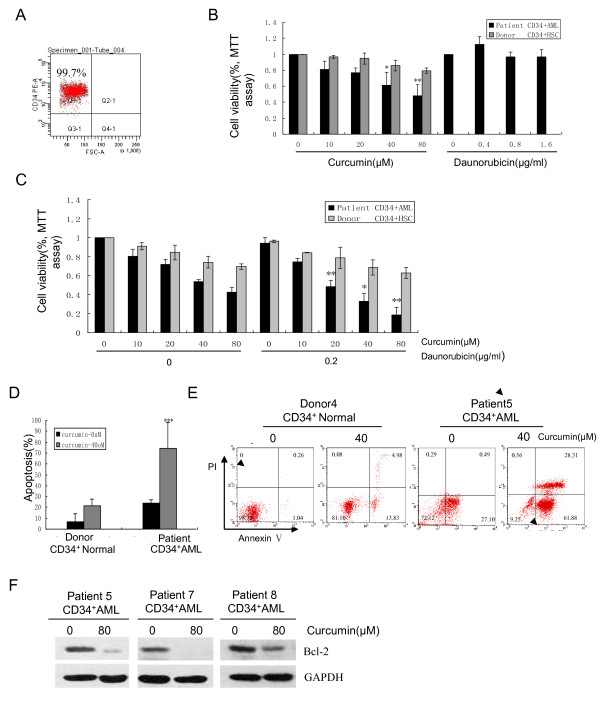
Curcumin was effective against primary CD34+ AML cells. (A) Primary CD34+ cells isolated from BMMCs or PBMCs of 9 AML patients and 8 healthy donors were isolated and subjected to flow cytometry to determine the purity of CD34+ cells. (B) 3 CD34+ AML and 3 CD34+ normal samples were treated with different concentrations of curcumin (0, 10, 20, 40, and 80 μM) for 24 h. The same CD34+ AML samples were also exposed to DNR (0, 0.4, 0.8, and 1.6 μg/ml) for 24 h. MTT assay was performed. The bar represents mean ± SD of three independent experiments. (C) Another set of 3 CD34+ AML samples and 3 CD34+ normal samples were exposed to different concentrations of curcumin, DNR, and their combination as indicated, for 48 h. MTT assay was performed. * P < 0.05, ** P < 0.01 (compared with either curcumin or DNR alone). (D, E) 4 CD34+ AML samples and 3 CD34+ normal samples were treated with 0 and 40 μM curcumin for 24 h. Apoptosis was assessed by AnnexinV/PI assay. The graph displays the mean ± SD of four independent experiments (D). A representative figure is shown (E). (F) 3 CD34+ AML samples were treated with 0 and 80 μM curcumin for 24 h. Bcl-2 protein levels were determined by Western blotting assay.